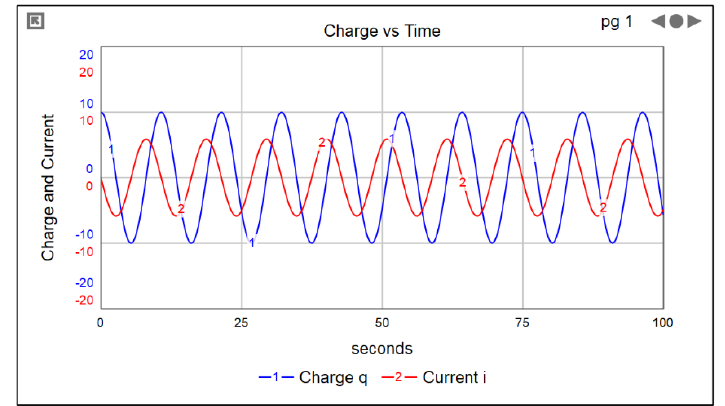
Fig. 23. Stella model output for LC